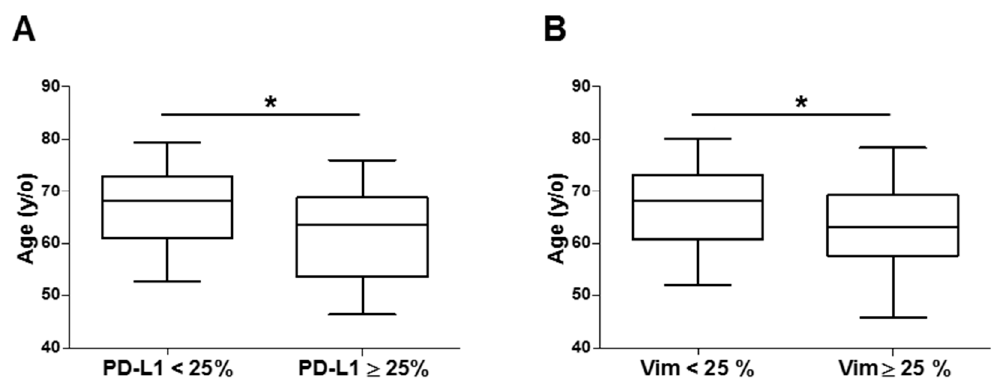
Figure A1. PD–L1 was correlated with age. ( A ) Younger cases expressed higher PD–L1 level. Tumors samples divided into high ( n = 47) and low ( n = 141) PD–L1 expression. ( B ) Younger cases expressed higher vimentin level. Tumors samples divided into high ( n = 30) and low ( n = 158) vimentin expression. Data are presented with boxplots as median ± 95 percentile. * p < 0.05.